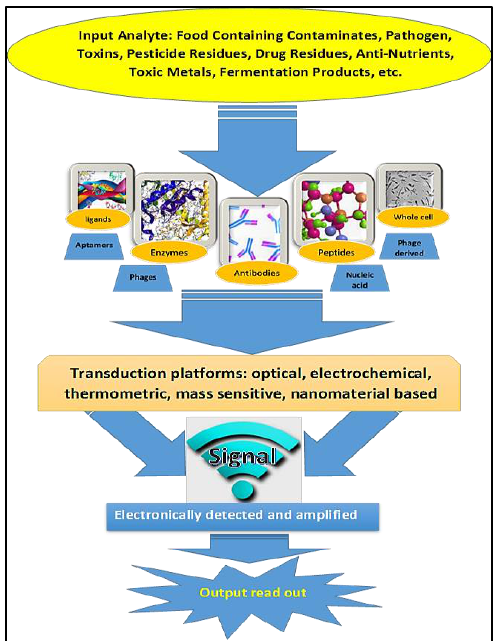
Figure 1. Diagram showing the different components of a biosensor used in food analysis.